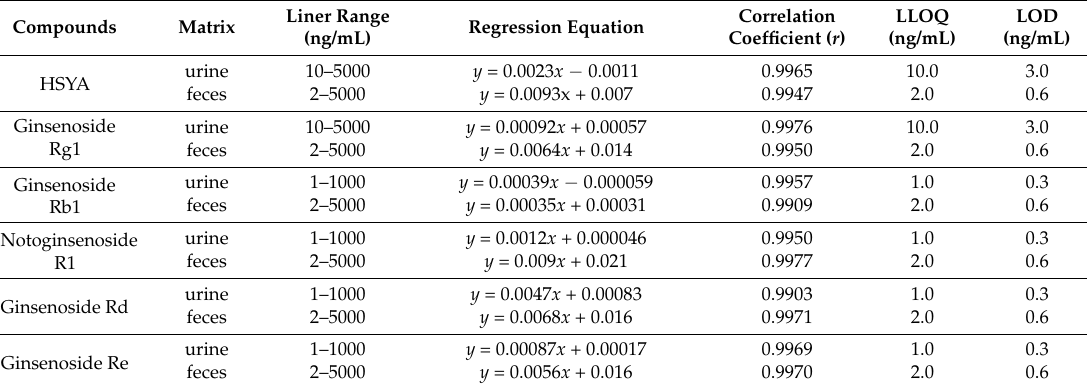
Table 2. Liner range, regression equation, and correlation coefficient of six compounds in urine